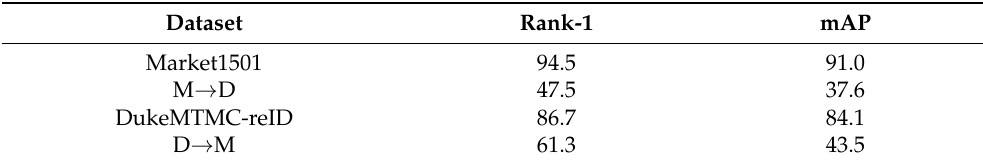
Table 1. The performance of different models evaluated on cross-domain datasets. M → D means that we train the model on the Market1501 and evaluate it on the